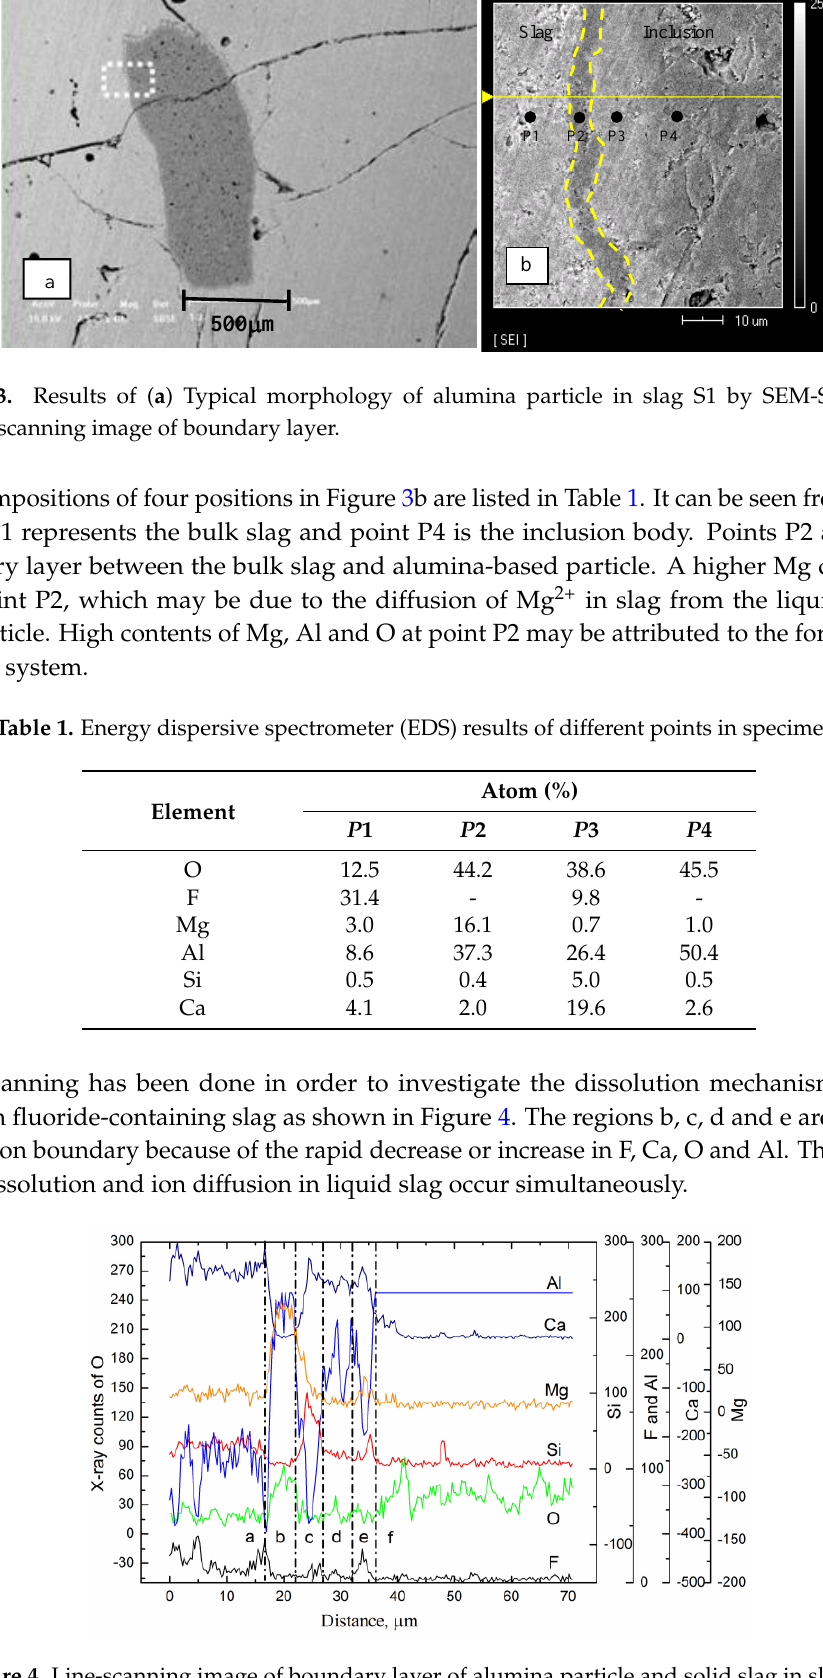
Figure 4. Line-scanning image of boundary layer of alumina particle and solid slag in slag S1.